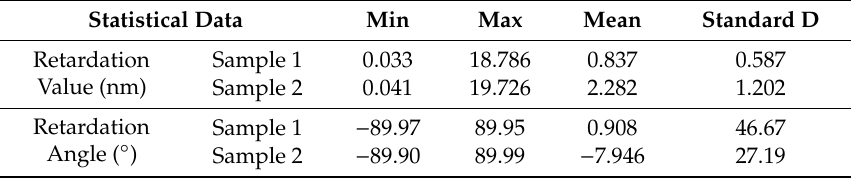
Table 1. Statistical data of retardation values and retardation angles in Figure